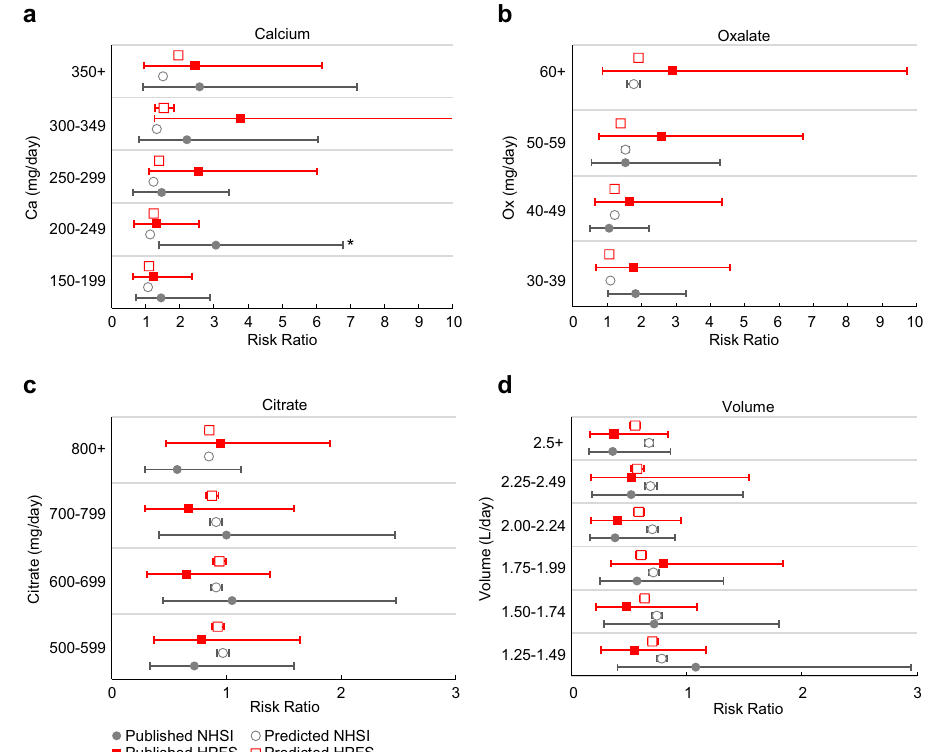
Fig. 3 Comparisons of the published Curhan 45 HPFS and NHSI populations relative risk ratios to numerically predicted risk ratios. The numerical estimates utilize sample populations derived from the published mean and standard deviation for each urine constituent: a calcium, b oxalate, c citrate, and d urine volume. The combined case ’ s and control ’ s urine constituent statistics were used to create a gamma distribution which was then sampled, to create 10,000 representative urine samples for the sample population predictions. Markers illustrate the mean value of each referent and predicted population and the whiskers represent the 95% con fi dence intervals of the mean. * indicates that the published and predicted pair show a statistically signi fi cant difference with P <